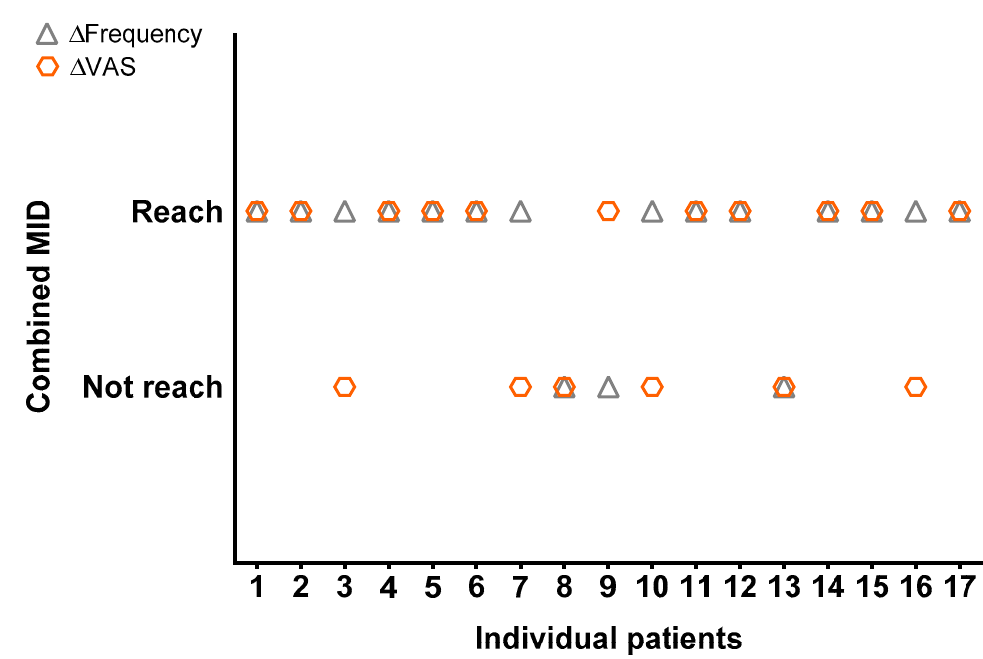
Figure 3. Individual combined evaluation of MID in VAS score and total urinary frequency at week 12. Table 2. Comparison of demographic characteristics between patients that reached the primary endpoint (responders) and those who did not